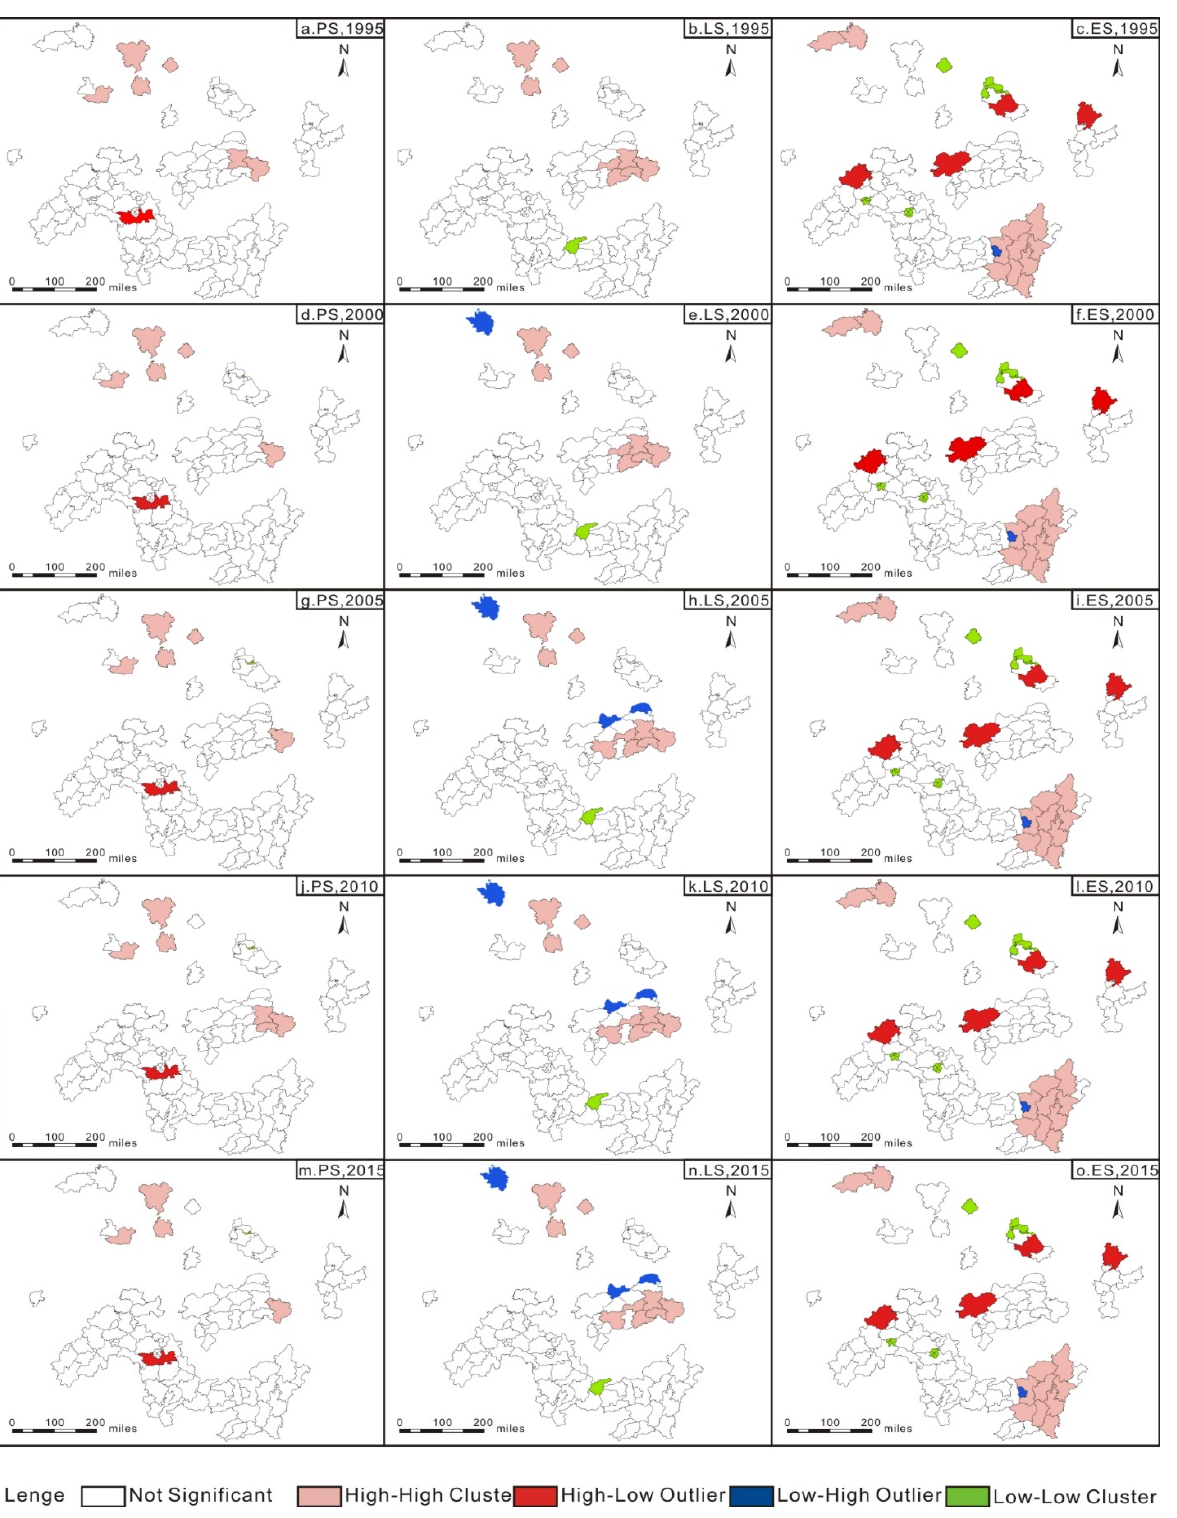
Figure 4. Local spatial autocorrelation results of the PLES of the non-resource-based cities, 1995–2015. We measured the degree of functional coordination spatially by local spatial auto- correlation analysis. The local spatial autocorrelation results of resource-based cities in the middle reaches of the Yangtze River show: high-high aggregation and low-low aggregation characteristics indicate that the functional coordination degree of a single county